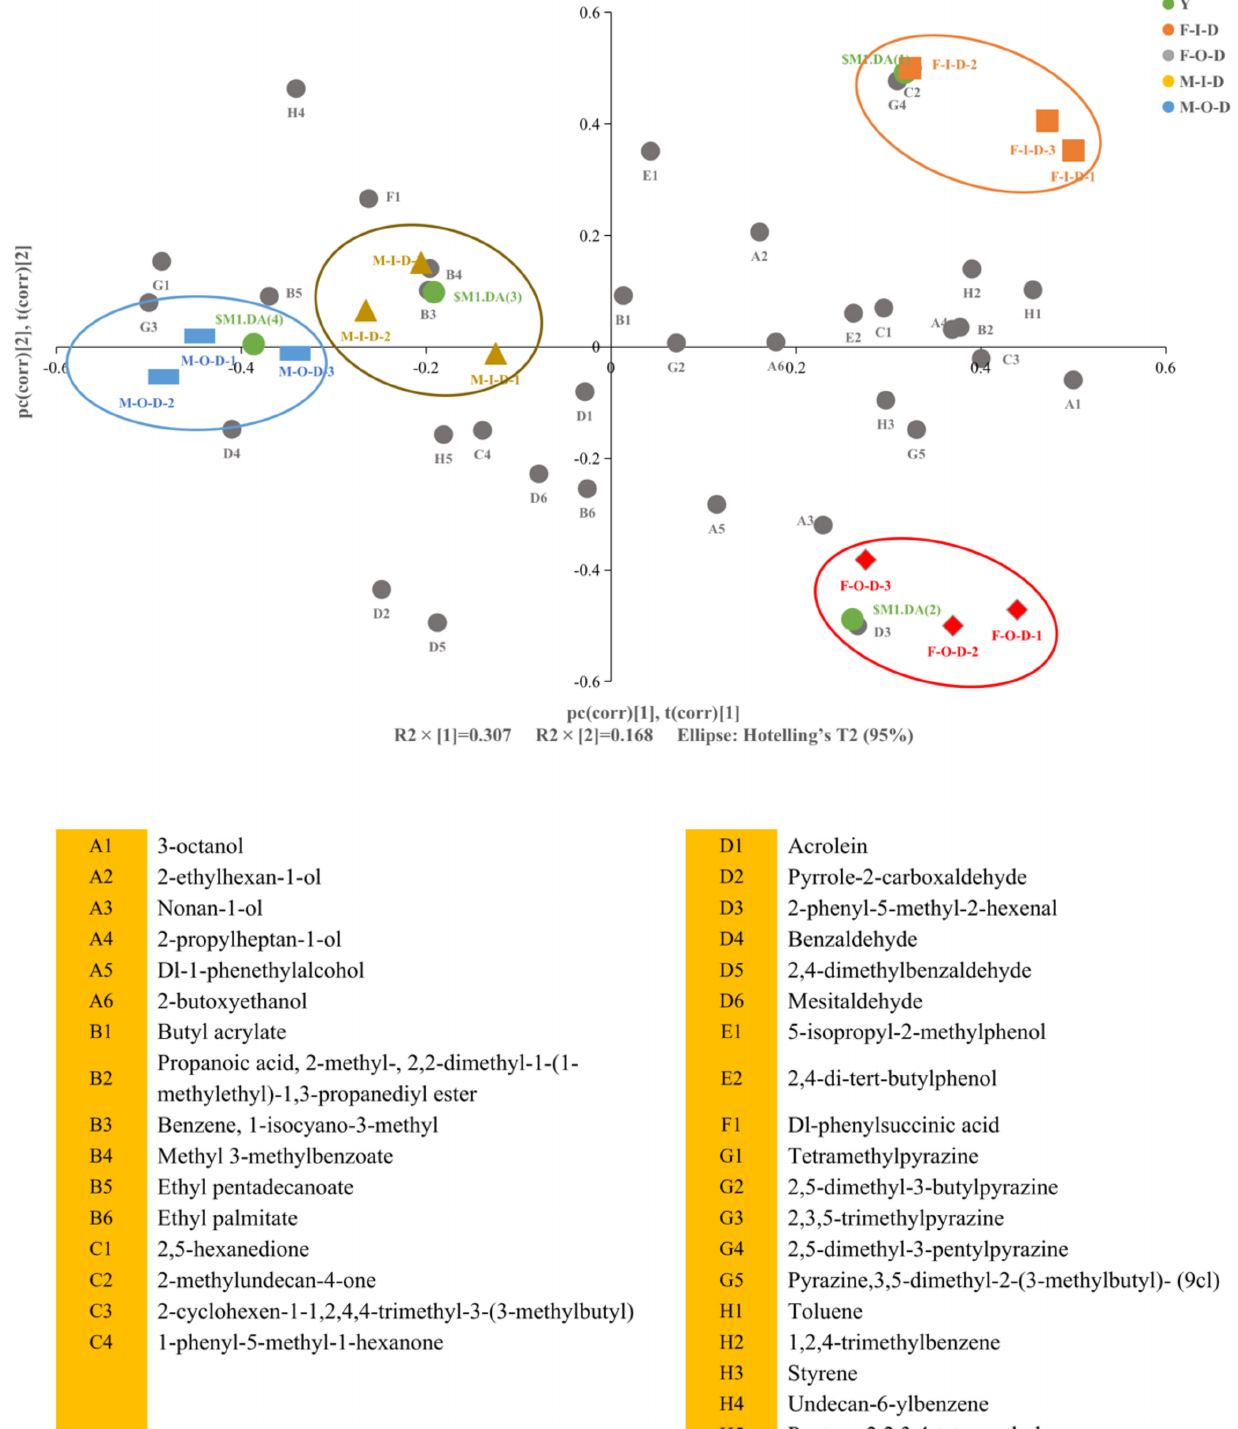
FIGURE 2 | Partial least squares discriminant analysis (PLS-DA) analysis of flavor compounds in Daqu samples. F-I-D: Inner of fresh Daqu ; F-O-D: Outer of fresh Daqu ; M-I-D: Inner of mature Daqu ; M-O-D: Outer of mature Daqu . X: “ • ” means flavor compounds. Y: “ • ” defines the different classes membership of Daqu samples in PLS-DA model. Biplot superimposed the scores and loadings of PLS-DA. The middle number in the sample code represents different plants.